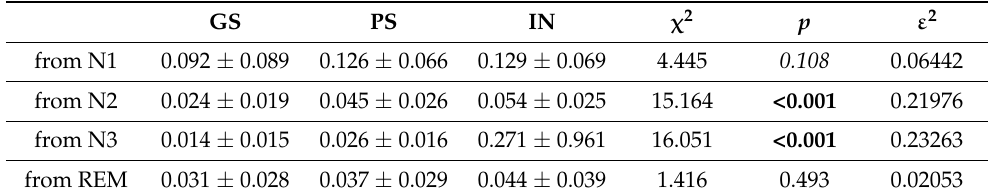
Table 3. Frequency of awakenings from specific sleep states in the three groups.